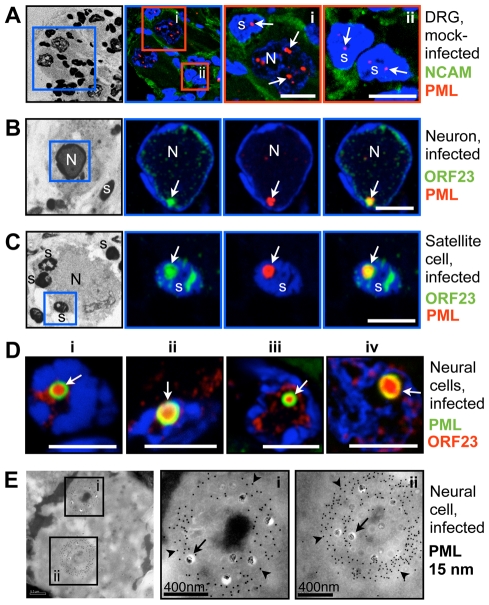
PML cages sequester VZV nucleocapsids during infection of human Dorsal Root Ganglia (DRG).Human DRG xenografts in the SCID mouse model were collected 14 days after mock infection (A) or inoculation with VZV (B–E) and fixed in 4% paraformaldehyde. Semithin (500 nm) cryosections were analyzed by confocal IF microscopy after staining for (A) Neural Cell Adhesion Molecule (NCAM) and PML, or (B–D) ORF23 and PML, as indicated at the right of each row of panels. Nuclei are stained with Hoechst (blue). Images in A-C (left panels) show overviews of the same DRG sections after Hoechst staining using an inverted grey scale. Blue or red squares demark areas shown at higher magnification in the adjacent panels. (A) Uninfected DRG sections show numerous small PML-NBs (red, white arrows) in the nuclei of neurons (N) and satellite cells (s). (B, C) VZV infected neurons and satellite cells with PML-NBs (white arrows) in which PML (red) colocalizes with ORF23 capsid protein (green). Scale bars are 5 µm. (D) Four examples (i–iv) of neural cells in infected DRG with large ring-like PML cages (green, white arrows) that sequester ORF23 protein (red). ORF23 capsid protein was present in 87% (N = 116) of PML-NBs within infected neural cells. Scale bars are 5 µm. (E) PML-specific immunogold-labeling of ultrathin (80 nm) cryosections of infected human DRG shows large ring-like PML cages (PML, 15 nm; arrowheads) that sequester numerous VZV NCs (arrows) in infected neural cells in human DRG. Areas in the black squares (i and ii) are shown at higher magnification in panels at the right. Sizes of scale bars are as indicated.